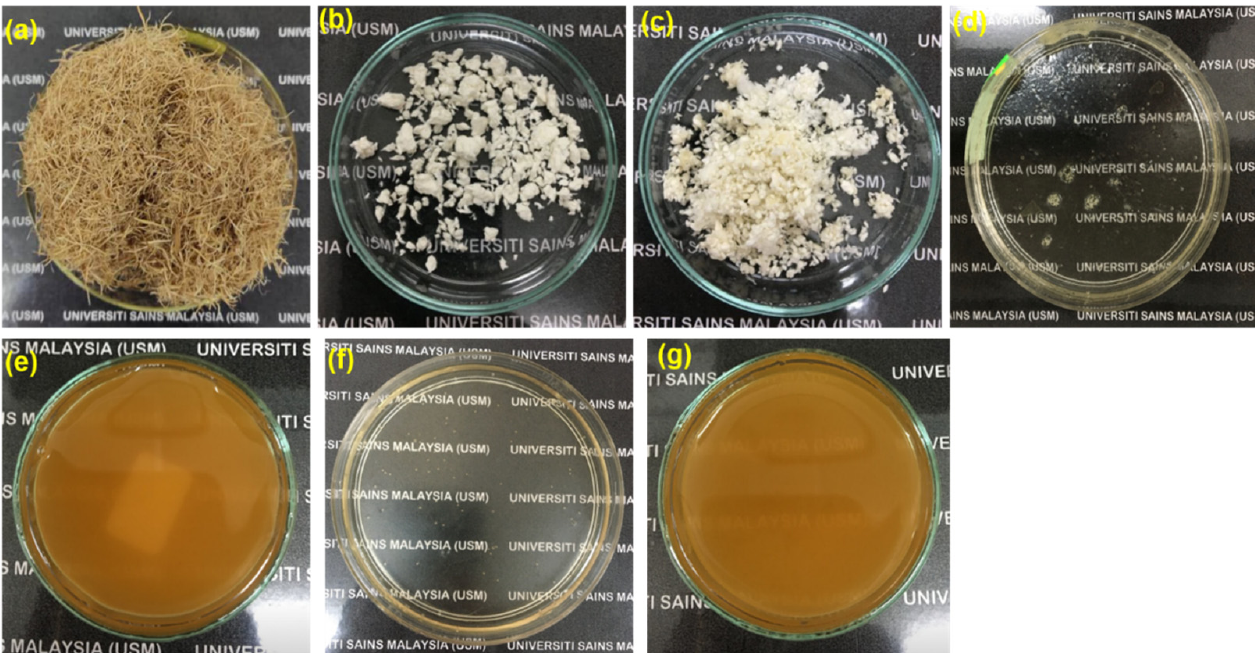
Figure 1. The appearance of pulped OPEFB ( a ), extracted cellulose from the pulped OPEFB ( b ), OCMC ( c ), films of OCMC ( d ), and OCMC/BFO ( e ); CCMC ( f ) and CCMC/BFO ( g ).